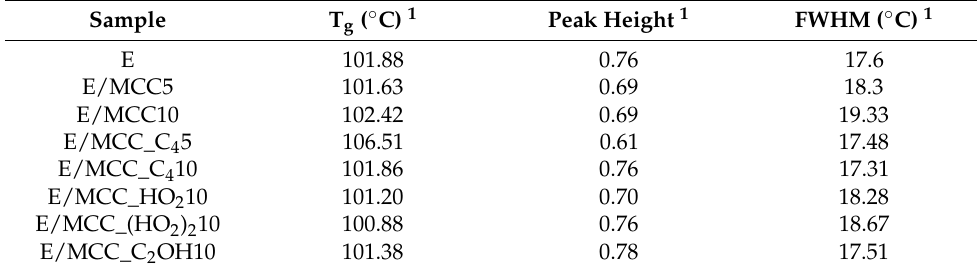
Figure 8. Loss modulus curves for epoxy and the MCC/epoxy composites. Table 7. Damping curves-derived results for epoxy and the MCC/epoxy composites.